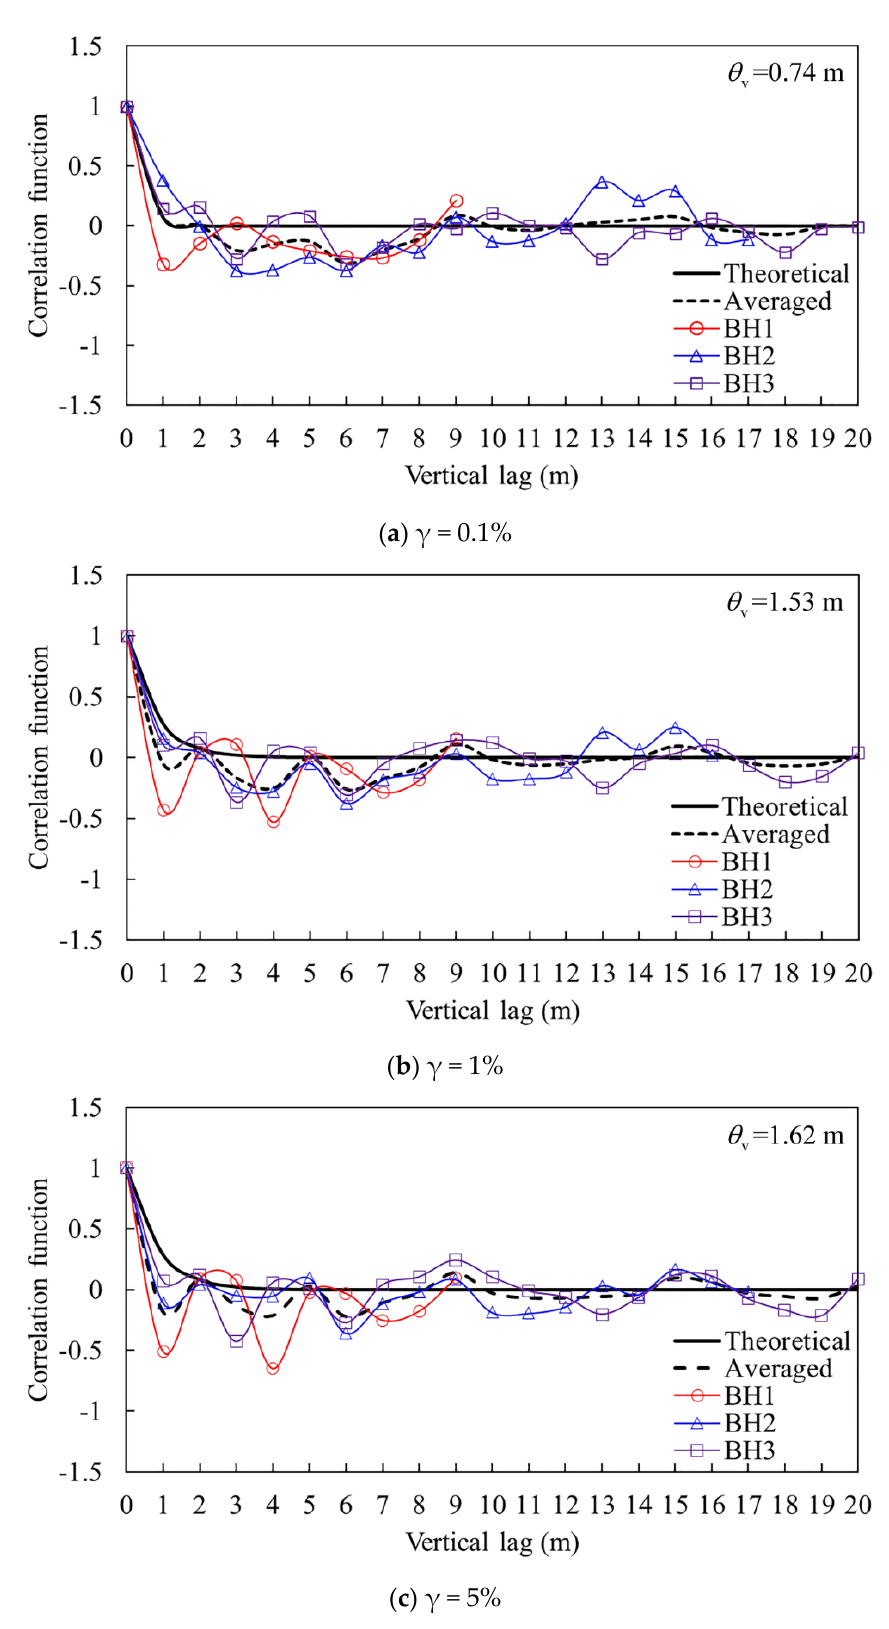
Figure 18. Vertical correlation lengths of the secant shear modulus at different shear strains.